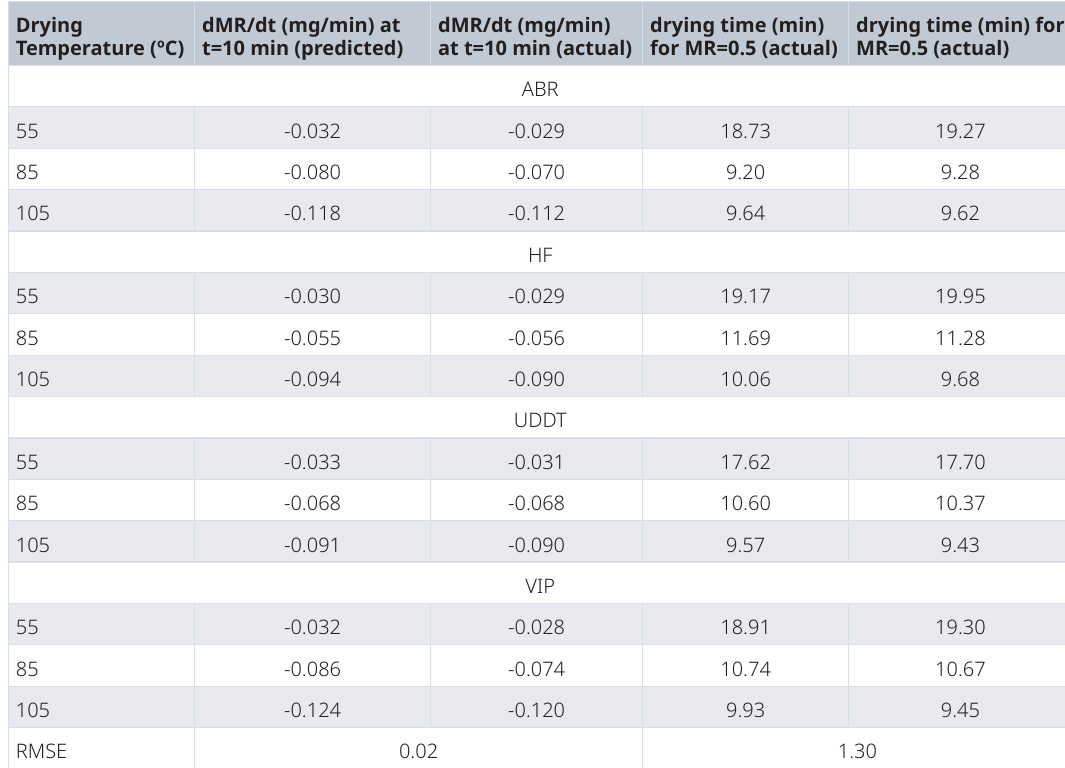
Table 8. Drying rate for t=20 min and drying time for MR=0.5 using Page Model at drying temperatures between 55 and 105ºC. Drying dMR/dt (mg/min) at Temperature (ºC) t=10 min (predicted)